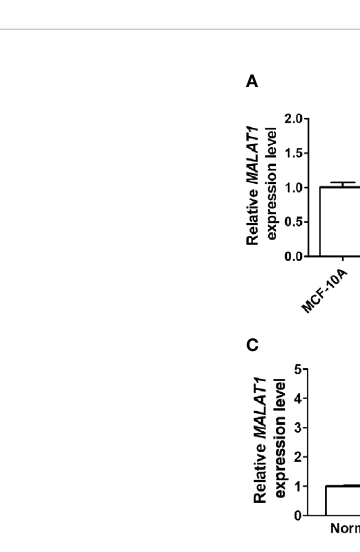
FIGURE 1 | MALAT1 is up-regulated under hypoxia in breast cancer cells. (A) Relative endogenous expression levels of MALAT1 in MCF-10A, MCF-7, and MDA- MB-231 cells. The expression levels were measured by qPCR. (B, C) Relative expression levels of MALAT1 in MDA-MB-231 (B) and MCF-7 (C) cells under hypoxia. (D) Relative expression levels of MALAT1 in MCF-7 cells treated with CoCl 2 . Data shown are the means ± SDs (n=3). * P <